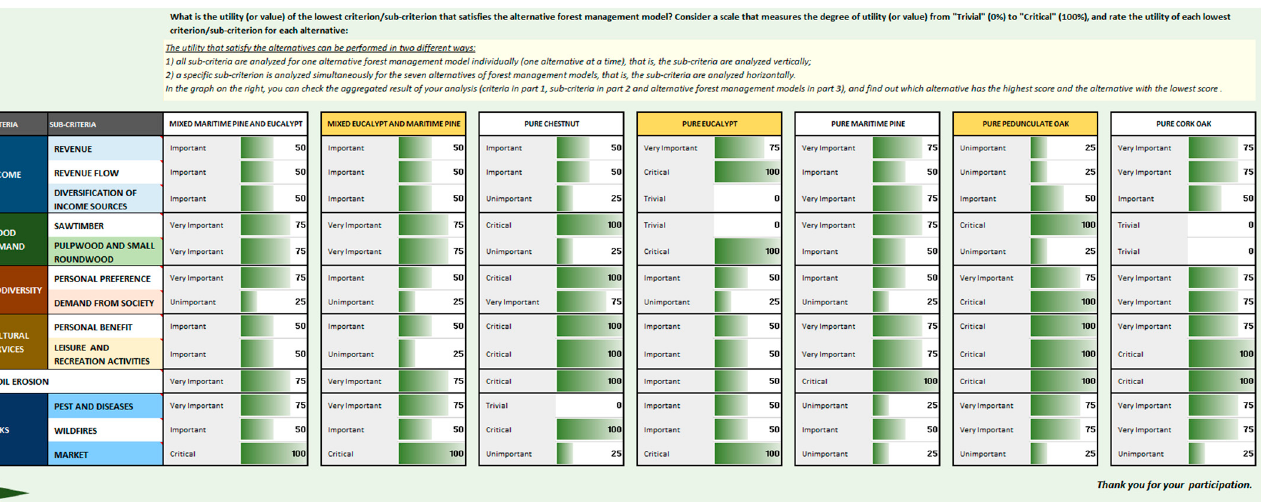
Figure 6. Multicriteria questionnaire to evaluate and rate the utility of the attributes of alternatives (columns) with respect to the lowest-level criteria or sub-criteria (rows).